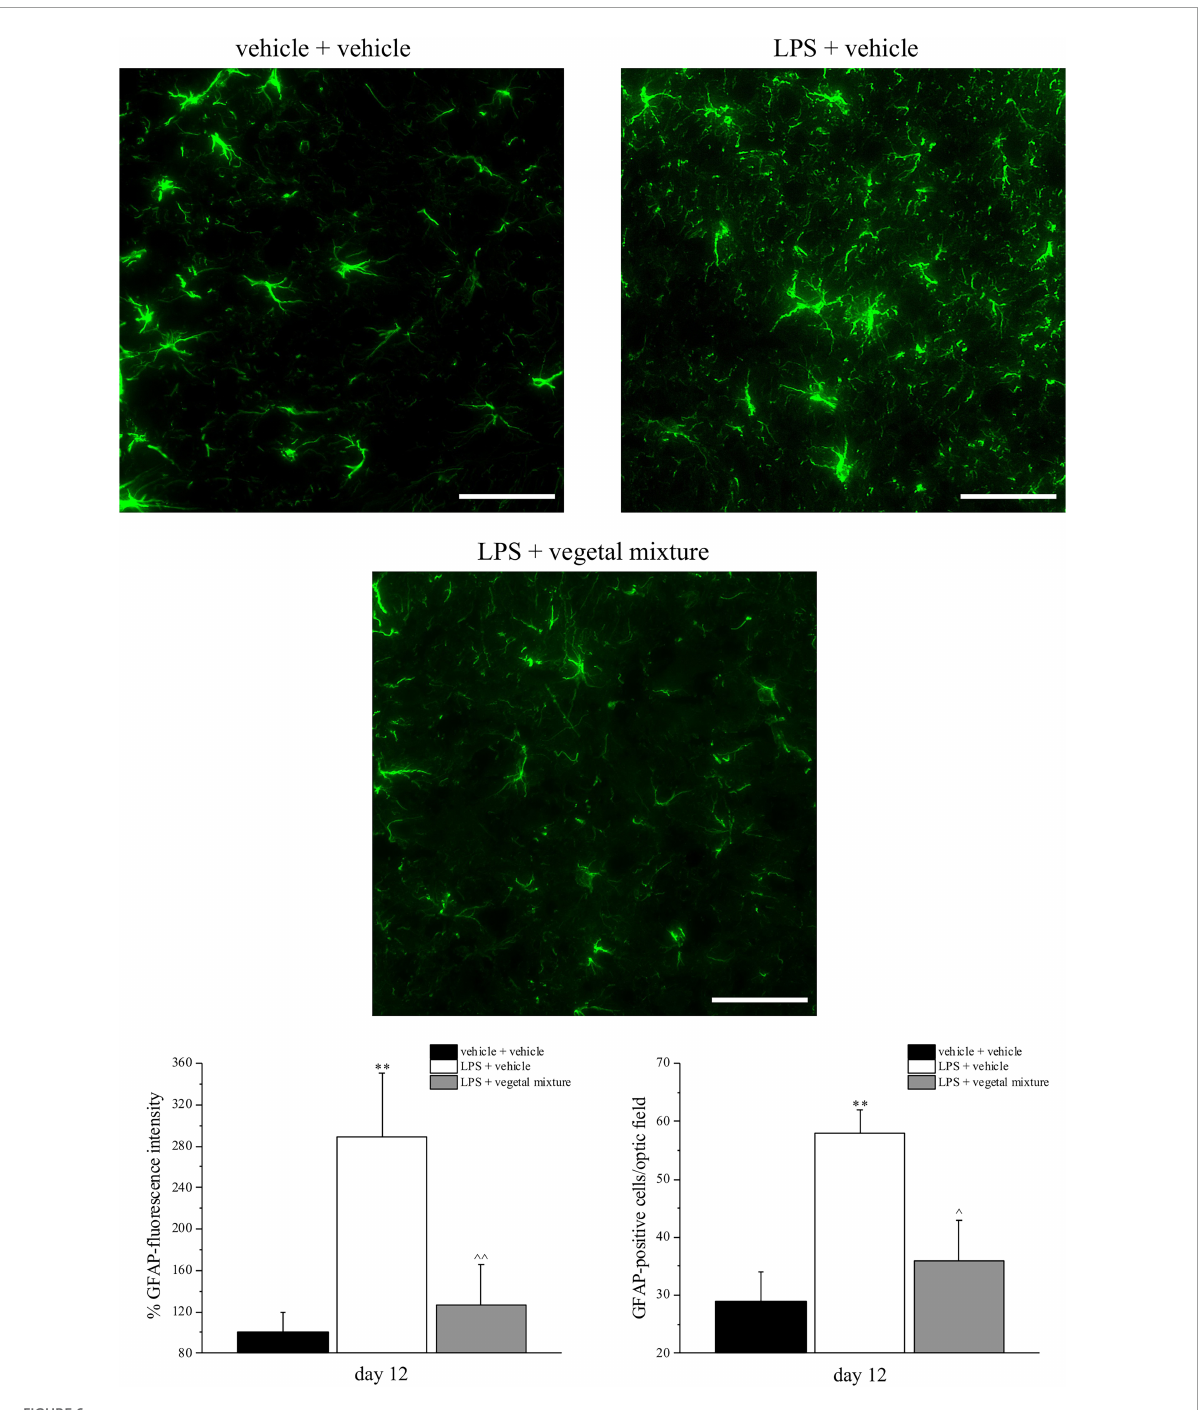
FIGURE6 Effect of a vegetal mixture on LPS-induced astrocyte activation. LPS (1 mg kg - 1 ) was intraperitoneally injected on days 1, 3, 5, and 8. The vegetal mixture was composed of Zingiber officinale (150 mg kg - 1 ), Echinacea purpurea (20 mg kg - 1 ), and Centella asiatica (200 mg kg - 1 ), suspended in 1% carboxymethylcellulose sodium salt (CMC) and orally administered daily starting from day 1 till the end of the experiment. Control animals were treated with vehicles. At the end of the behavioral experiments and 24 h after the last administration of the vegetal mixture, animals were sacrificed and the lumbar spinal cord was collected. The number of GFAP-positive cells was measured in the dorsal horn of the L4–L5 spinal cord. Transverse sections of the spinal cord were imaged with a × 40 objective lens (scale bar = 50 µ m). Histograms show the quantitative analysis of GFAP fluorescence intensity and the number of GFAP-positive cells/optic fields. Data are expressed as the mean ± SEM of values from eight mice analyzed in two different experimental sets. ∗∗ p < 0.01 vs. vehicle + vehicle; ∧ p < 0.05 and ∧∧ p < 0.01 vs. LPS +